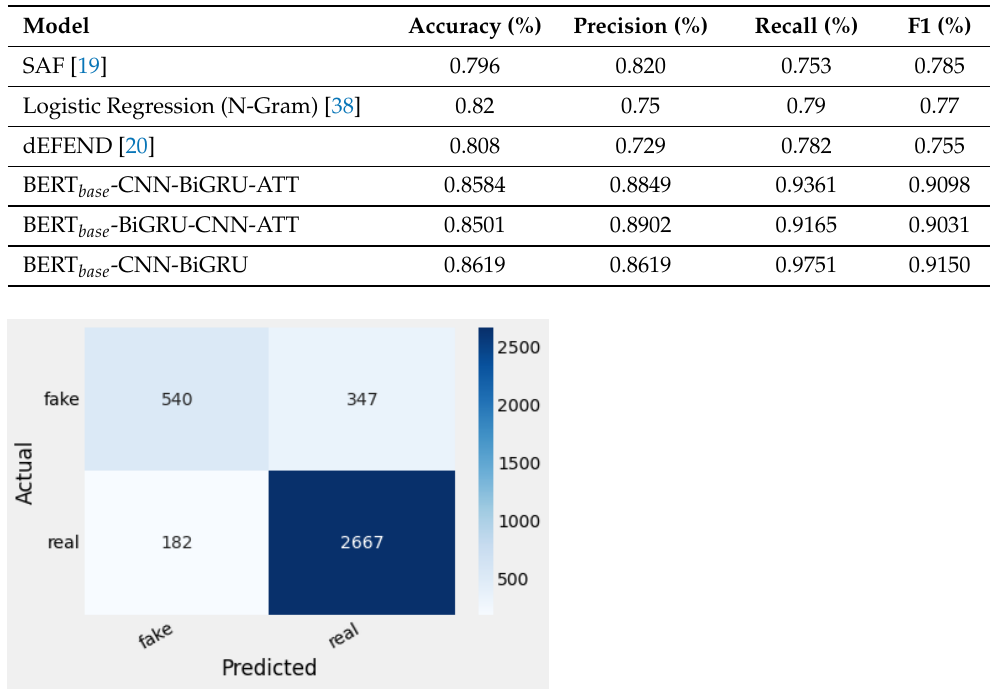
Figure 15. Confusion matrix of BERT base -CNN-BiGRU-ATT in GossipCop w/o user posting behavior features.